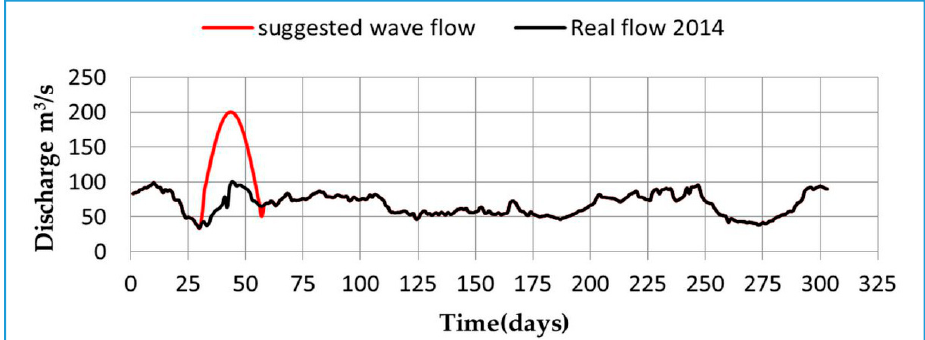
Figure 16. Suggested wave and real flow for the year 2014 behind the Qal’at Saleh regulator [25].